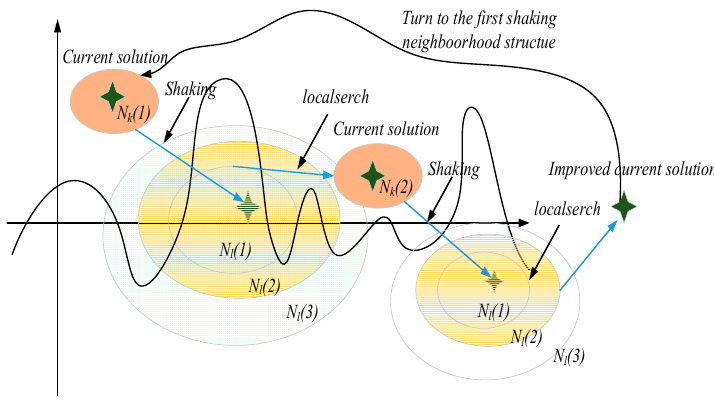
Figure 1. Conventional VNS concept diagram.